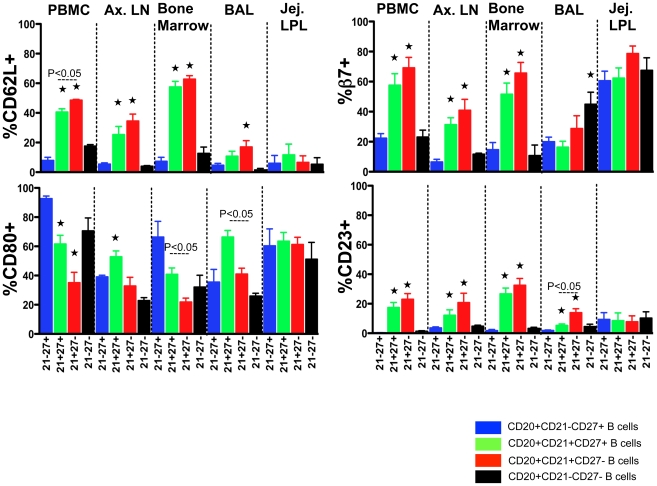
Relative expression of trafficking molecules (CD62L and β7), and activation receptors (CD80 and CD23) in different subpopulations of CD20+ B cells in both peripheral and lymphoid tissues from normal healthy macaques (mean ± standard error).Cells were gated first on singlets, and then on CD20+ B lymphocytes. All CD20+ B cells were further analyzed based on their CD21 and CD27 surface molecule expression. Statistically significant differences between DP CD21+CD27+ and SP CD21+ B cell subsets are shown.  Indicates significant differences between SP CD27+ B cells and other B cell subsets for the specified tissue.